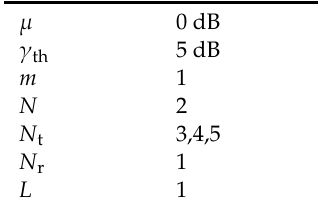
Table 2. The parameters for the TAS scheme.